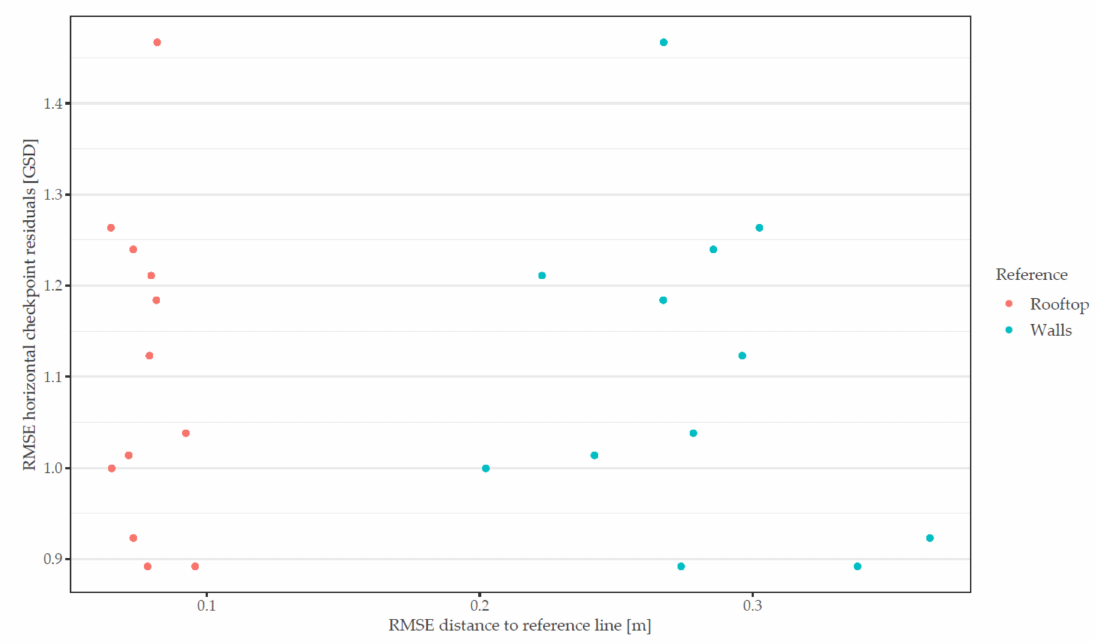
Figure 11. Scatterplot of error metrics for delineated rooftops and walls of orthophotos captured with di ff erent flight configurations. Absolute accuracy of the orthophoto is given on the y -axis with the RMSE of horizontal checkpoint residuals. Relative accuracy is shown on the x -axis displayed by the RMSE of point distances to reference lines. Note that both axes have di ff erent